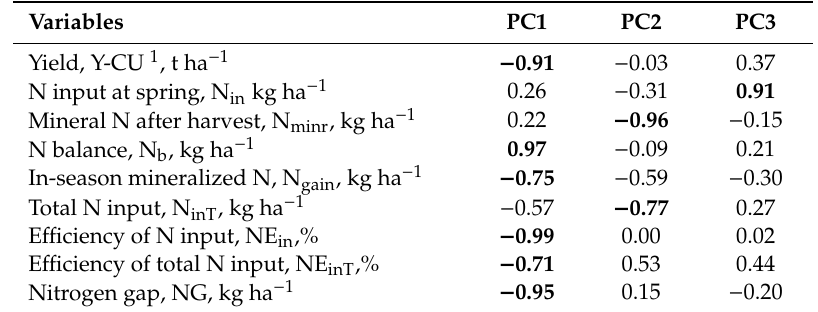
Table A4. Pearson’s correlation matrix between yield selected soil nitrogen variables and PCA factors for winter triticale, n =